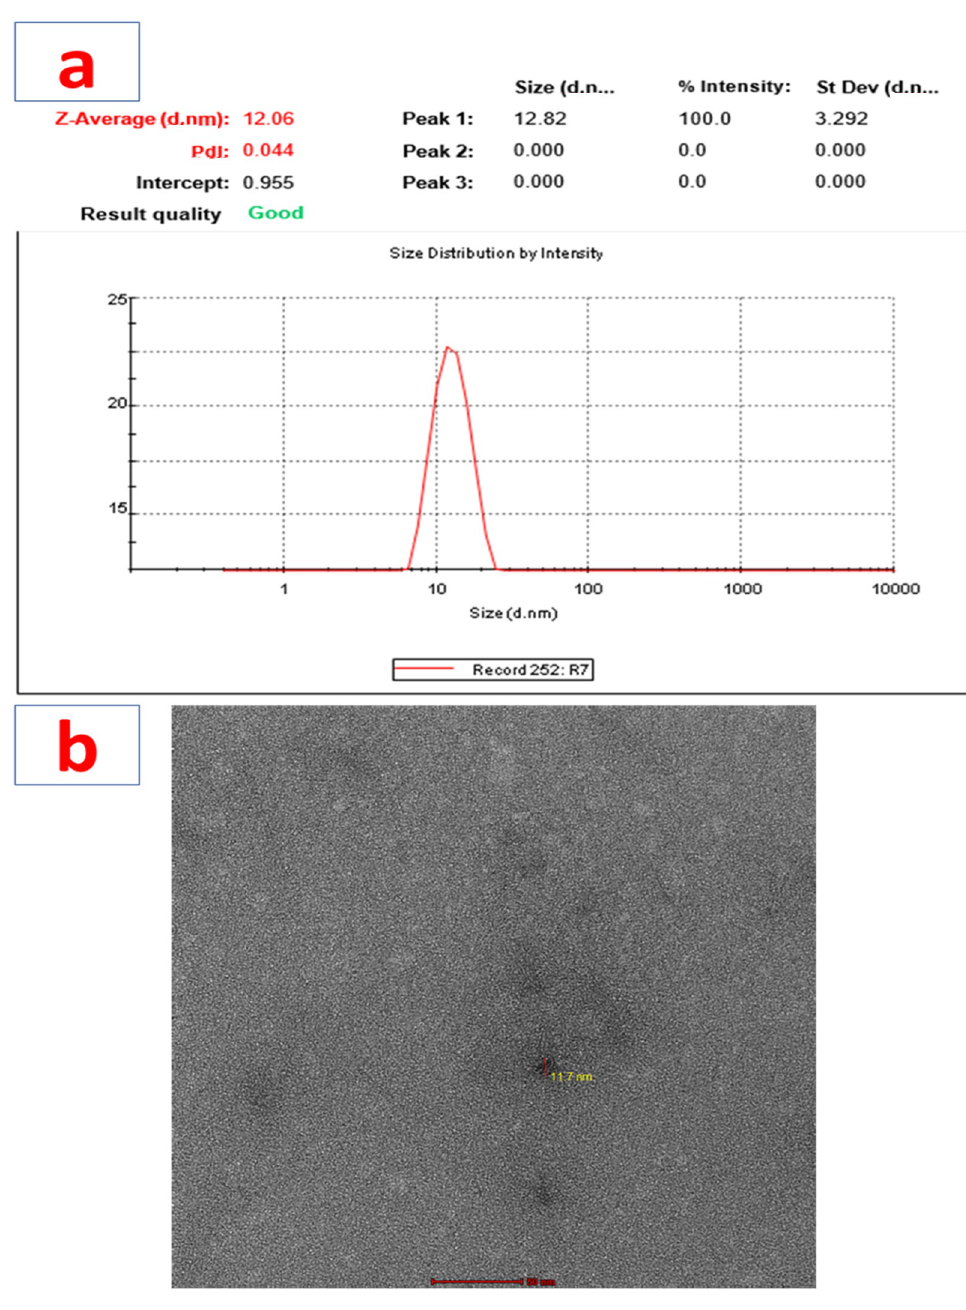
Figure 3. ( a ) Particle size determination using a Malvern Zetasizer and ( b ) particle morphology with TEM. with